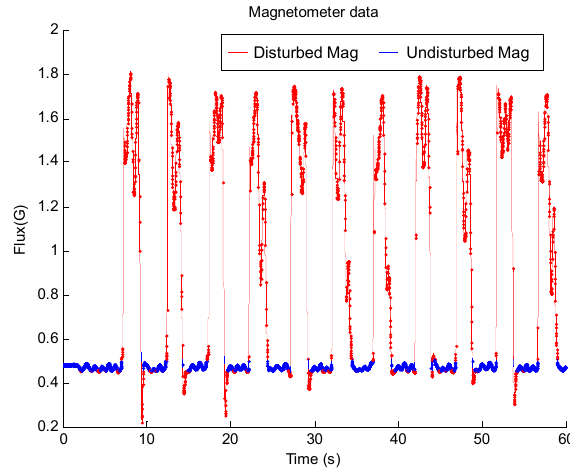
Figure 10. The magnitude of the measured magnetic field during dynamic test.